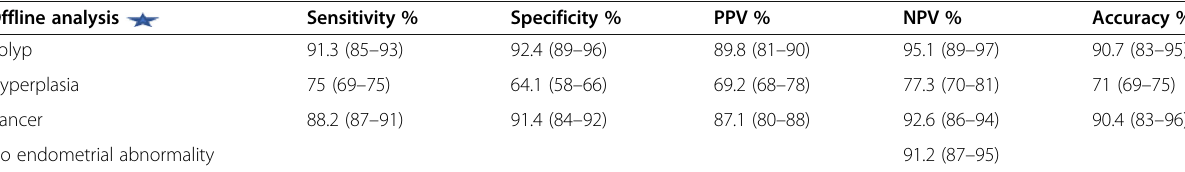
Table 2 Accuracy of offline analysis in the diagnosis of four endometrial categories (polyp, hyperplasia, cancer, and normal endometrium)